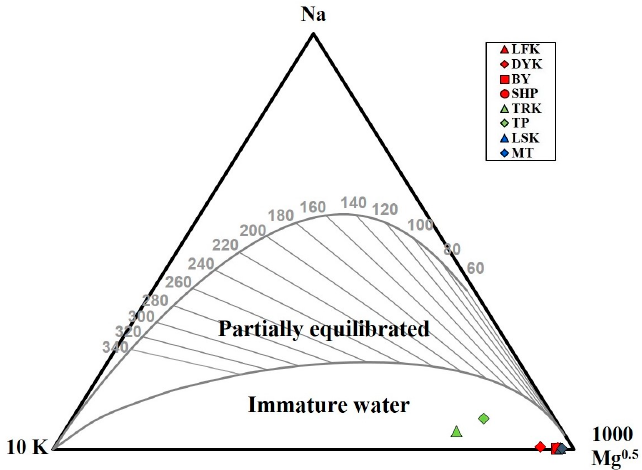
Figure 6. Na-K-Mg diagram for the Tatun geothermal field. Table 4. Mineral saturation index of the Tatun geothermal field.